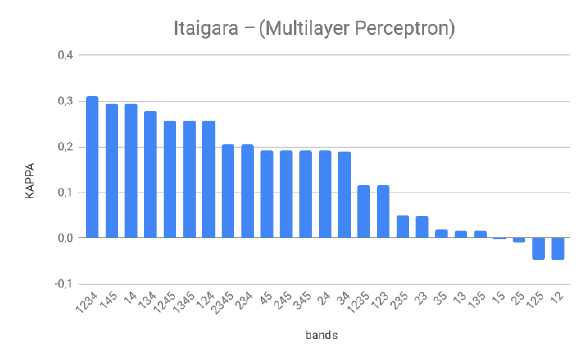
Figure 6 . Variation of the cover index due to the combination of bands in Itaigara.